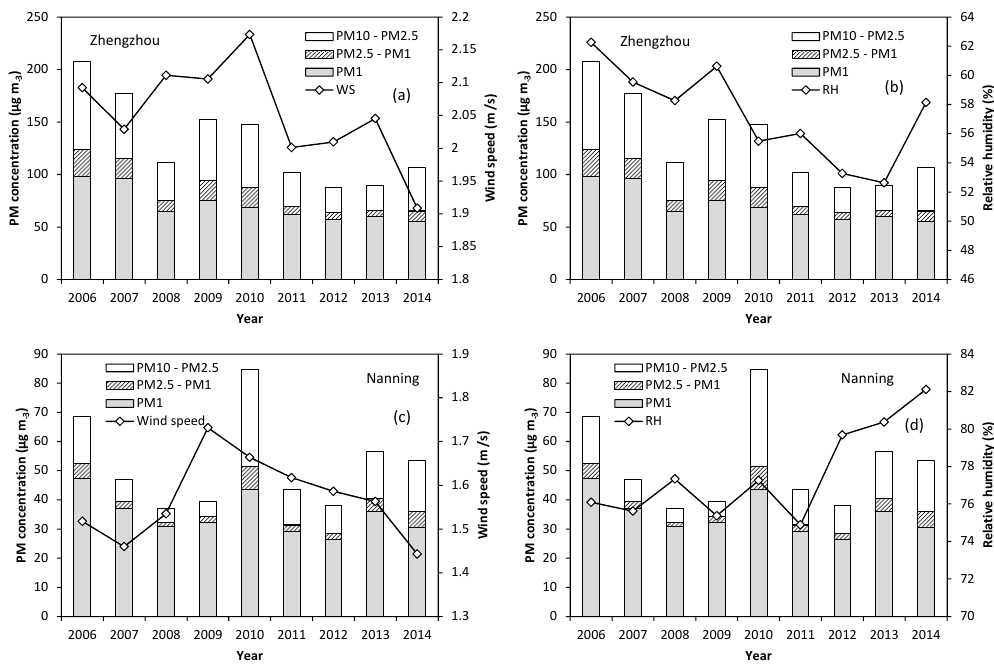
Figure 11. Interannual variation of PM 10 , PM 2 . 5 and PM 1 vs. wind speed and relative humidity at (a, b) Zhengzhou and (c, d)